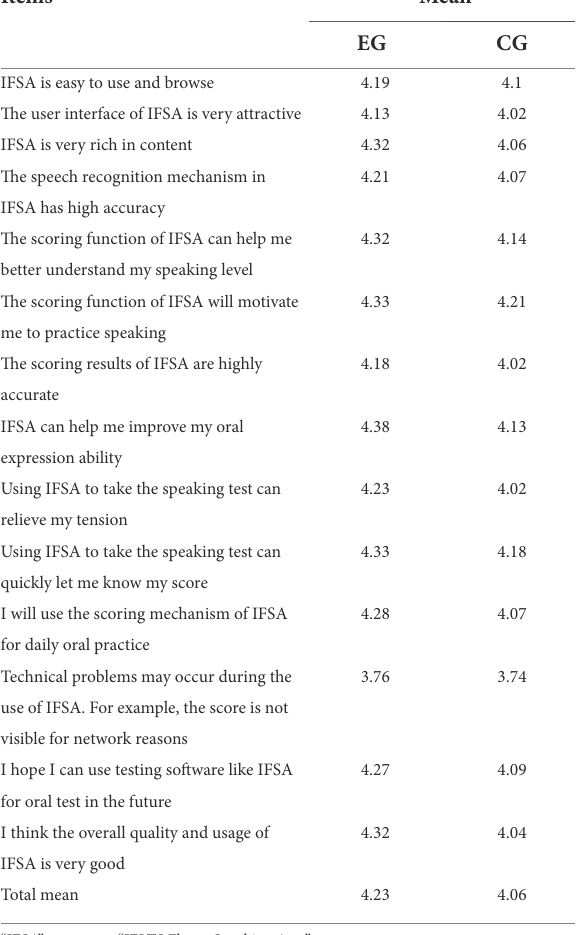
TABLE 2 The average score of the participants for the questionnaire about the IELTS Fluent Speaking App.